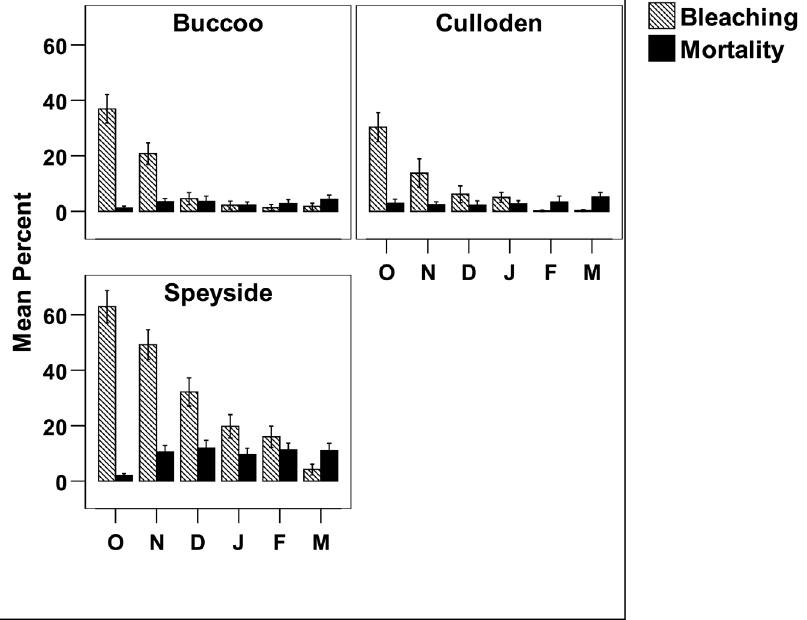
Figure 4. Mean percent coral bleaching and new mortality per month at Buccoo, Culloden and Speyside during the 2010 mass bleaching event (October 2010 to March 2011). Bars represent standard error. O=October 2010, N=November 2010, D=December 2010, J=January 2011, F=February 2011 and M=March 2011.